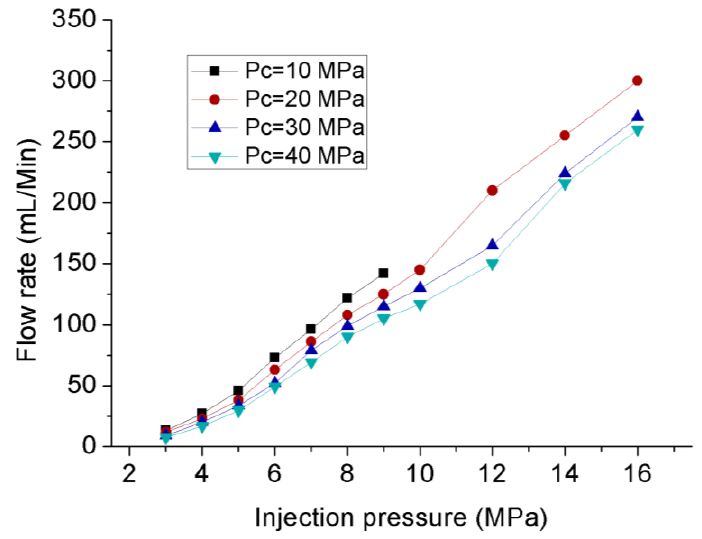
Figure 10. Flow rates for different injection pressures.